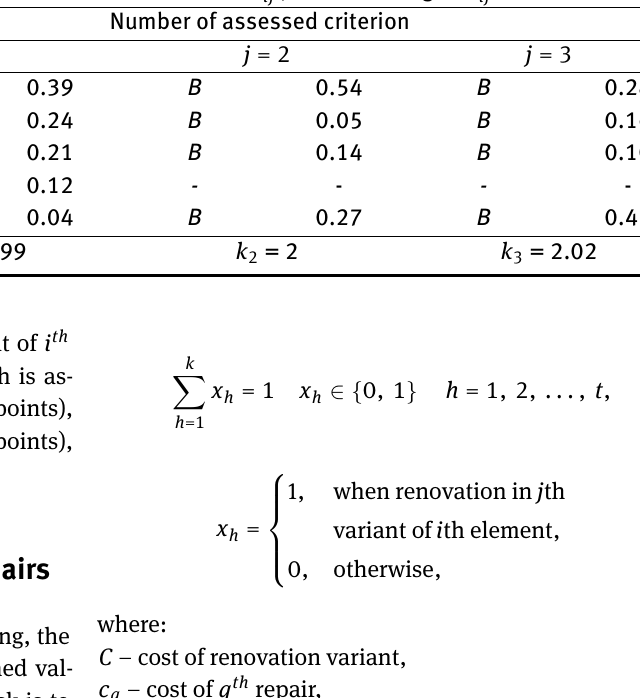
Table 2: Evaluation of the building according to the criteria k 1 , k 2 , k 3